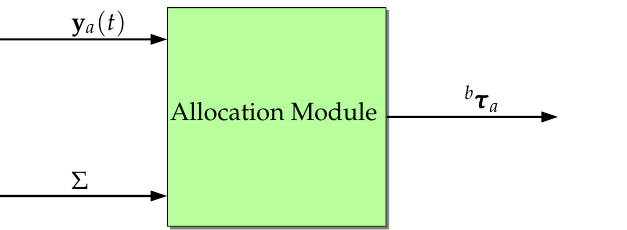
Figure 6. A graphic representation of the operation performed by the Allocation Module, with y a and H as inputs and b τττ a as output.